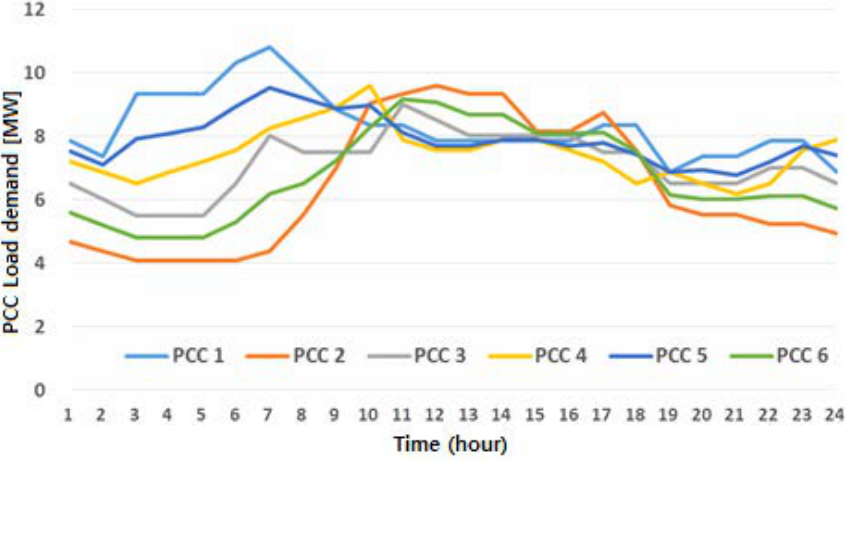
Figure 8. Load profiles for one day at six PCCs (each PCC consists of six